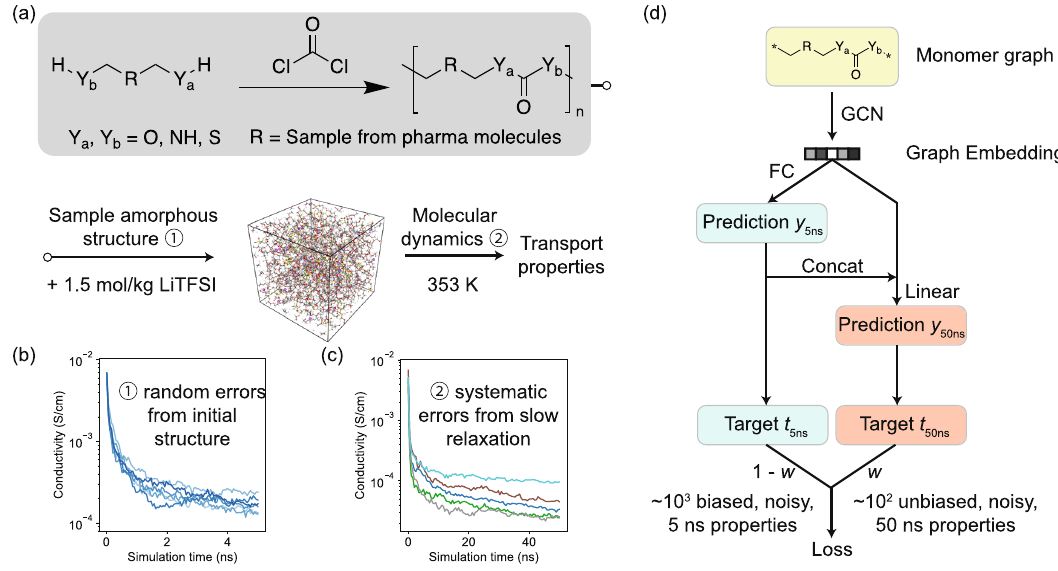
Fig. 1 Illustration of the polymer space and the learning framework. a The polymer space and molecular dynamics simulation work fl ow. b Ionic conductivity as a function as simulation time from six independent 5 ns MD runs for the same polymer, showing the random errors caused by the amorphous structure initialization. c Ionic conductivity as a function as simulation time for fi ve different polymers, showing the long simulation time needed for convergence. (Polymer structures for ( b , c ) are provided in the supplementary information.) d Multitask learning framework to reduce the random and systematic errors from MD